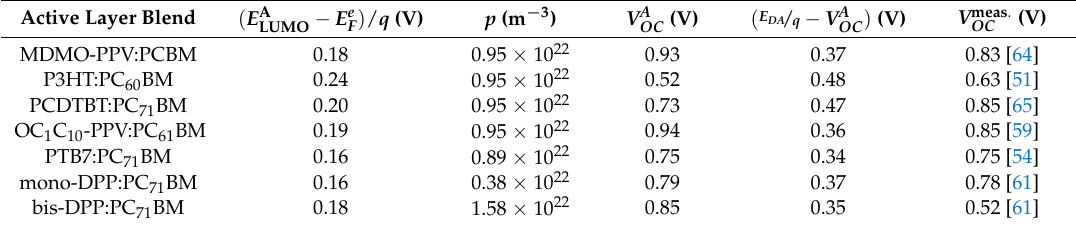
− E e ) / q and hole concentration p used in calculating F LUMO from Equation (15), the calculated voltage offset ( E DA / q − V A OC OC